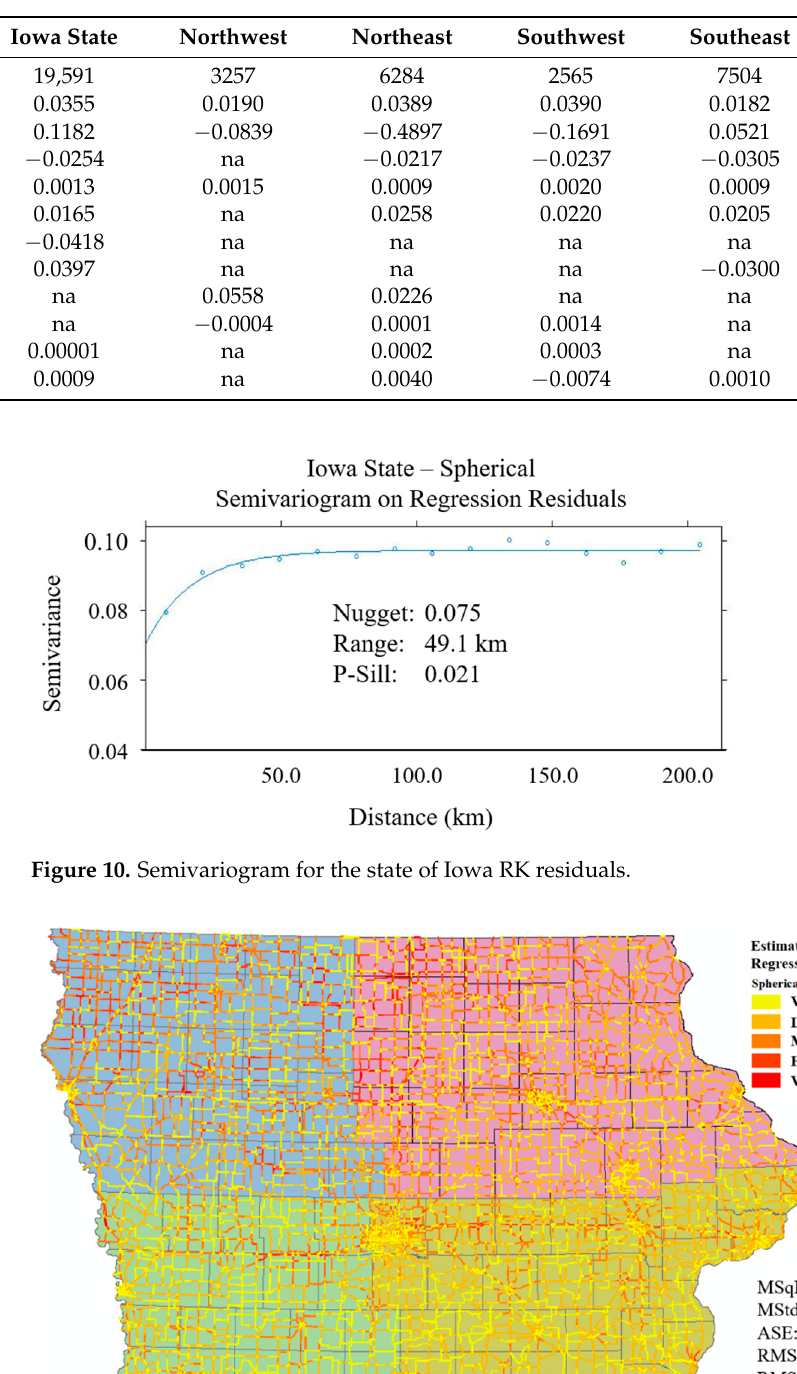
Table 4. Regression coefficients for each region.